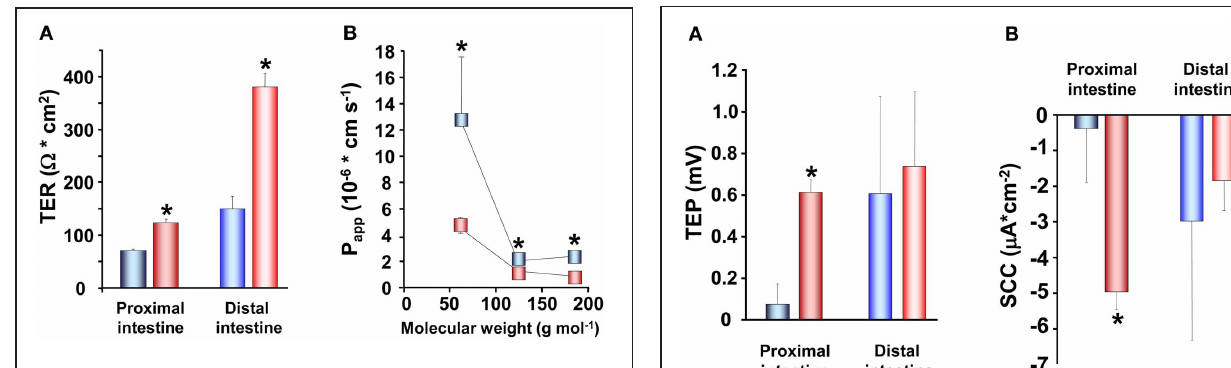
FIGURE 3 | Transepithelial resistance (TER; n = 8) in the proximal and distal intestine (A) and the apparent permeability coefficient (P app ; n = 16) (B) for three different sized hydrophilic permeability markers; 14 C-urea, MW:62, 14 C-erytritol, MW:124 and 14 C-mannitol, MW:184, in the proximal and distal intestine of fresh water ( , ) and seawater ( , ) adapted rainbow trout. (Values presented are means ± SEM). Asterisks indicate significant differences between FW- and SW-acclimated trout. All data are expressed as mean values ± SEM. Differences in the parameters measured are analyzed using Two-Way ANOVA followed by Student Neuman Keuls post-hoc procedure. Significance was accepted at p < 0 . 05 (see Sundell et al., 2003; Jutfelt et al., 2007; Sundh et al., 2009).